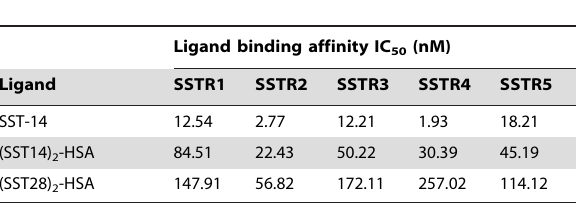
Table 1. Ligand binding properties of (SST14) 2 -HSA and (SST28) 2